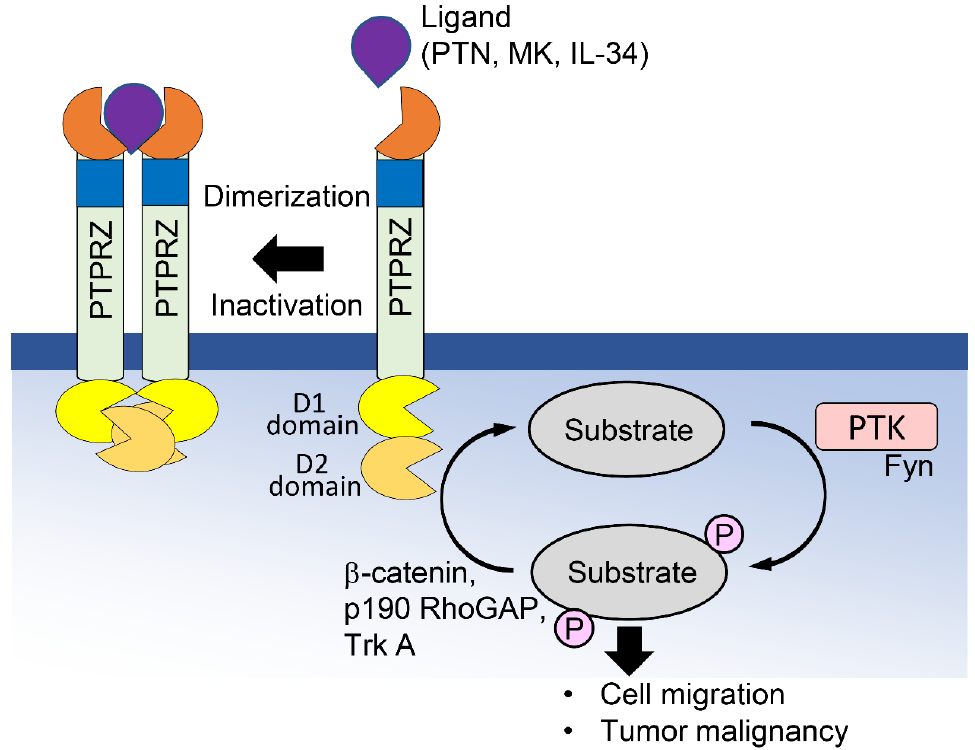
Figure 2. Mechanisms regulating the PTPRZ signaling pathway. PTKs, such as Fyn, phosphorylate downstream signaling molecules, such as β -catenin and p190 RhoGAP, leading to increased cell growth and migration. PTPRZ dephosphorylates these molecules. The binding of ligands induces head-to-toe dimerization of PTPRZ, which results in the masking of the catalytically active D1 domain, leading to its inactivation.